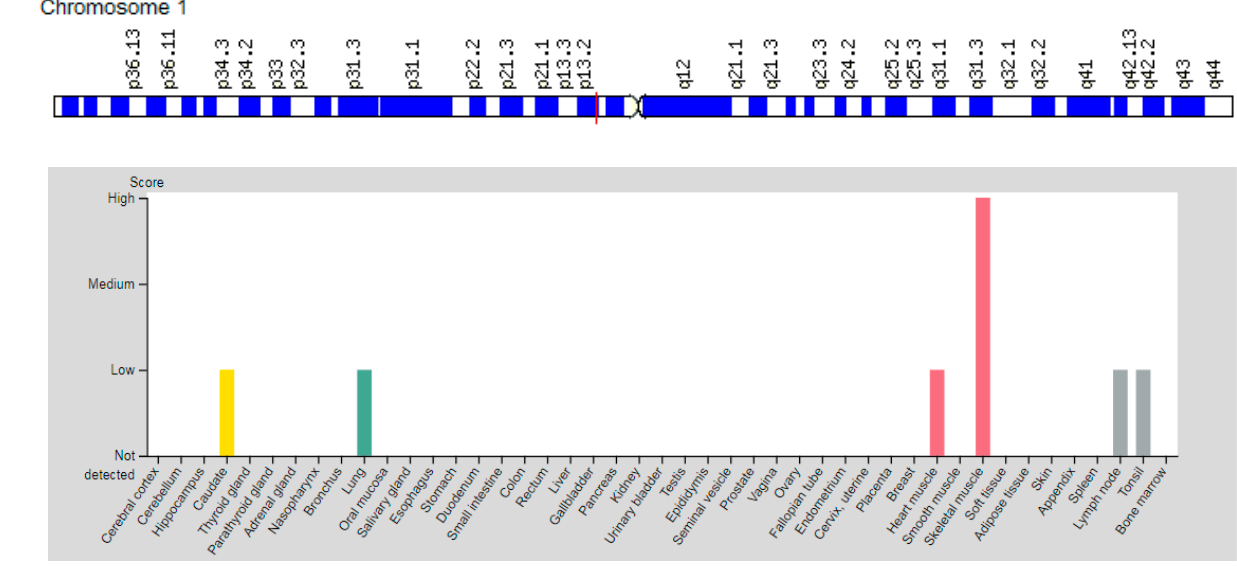
Figure 2. Location of the AMPD1 gene ( a ) and tissue expression of the adenosine monophosphate deaminase-1, muscle ( b